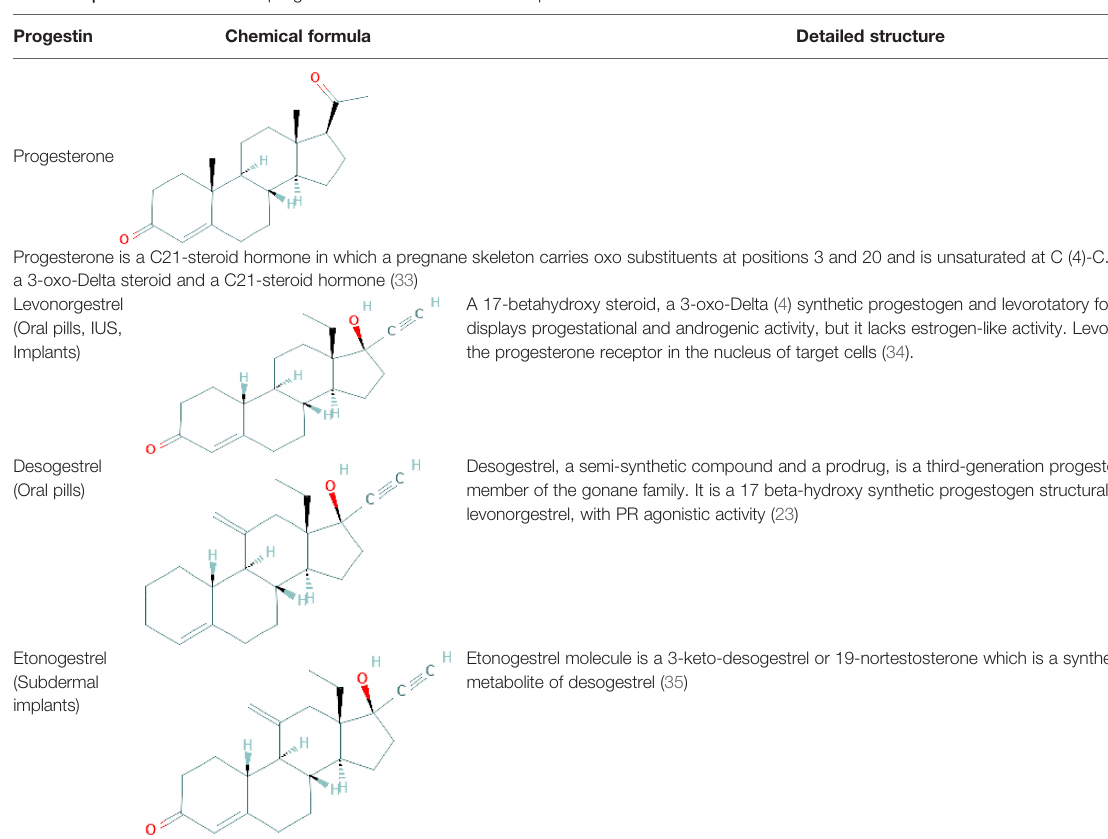
TABLE 1 | Chemical structure of progestins included in subdermal